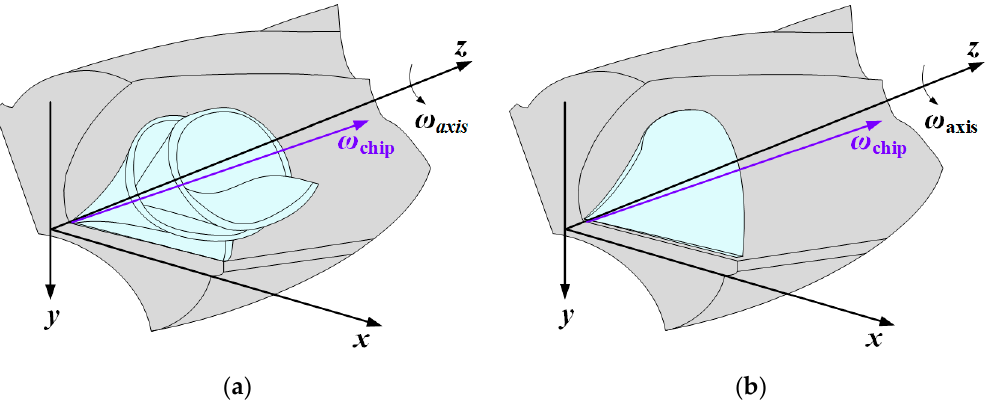
Figure 12. ( a ) Experimental and ( b ) simulated morphologies of the chips formed using PCD and CVD drills.